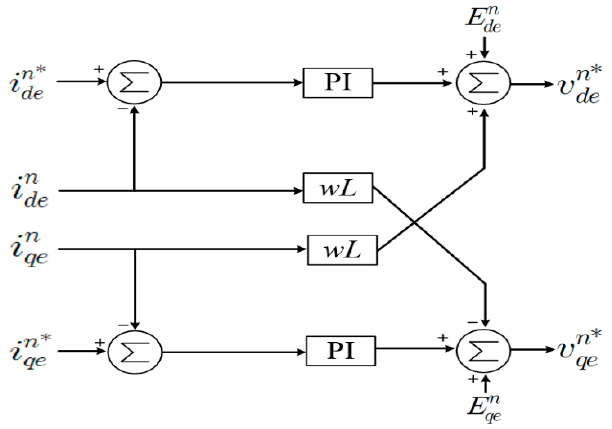
Figure 5. Control diagram of the negative sequence current (NSC).